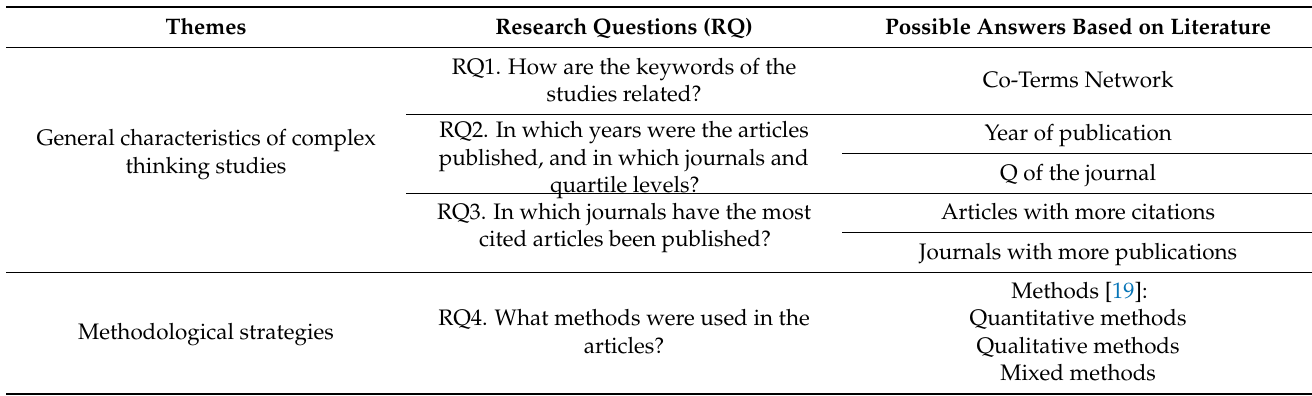
Table 1. Themes and research questions